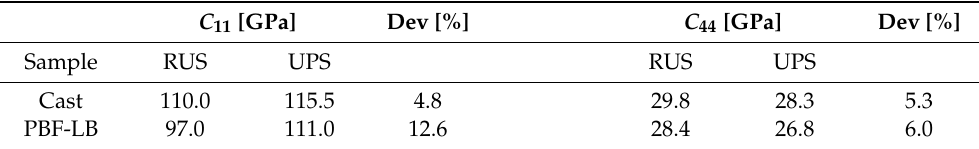
Table 5. Comparison between RUS and UPS measurements.